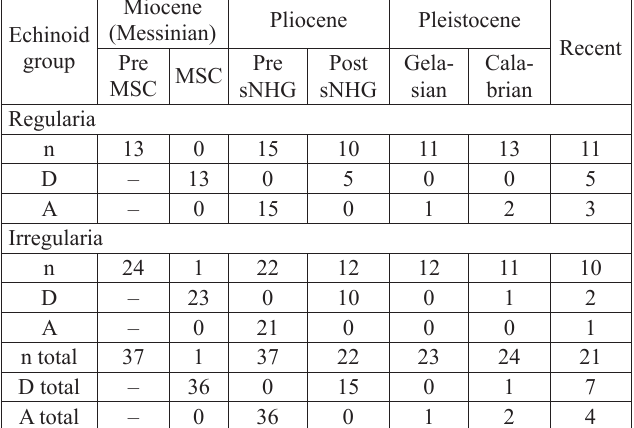
Table 1. Quantitative data of Mediterranean echinoid genera from Mes- sinian to Recent. n, number of genera; D, number of disappeared genera; A, number of appeared genera; MSC, Miocene salinity crisis; sNHG, setting of Northern Hemisphere glaciation. For each geological period appearances and disappearances are in relation to the previous one.